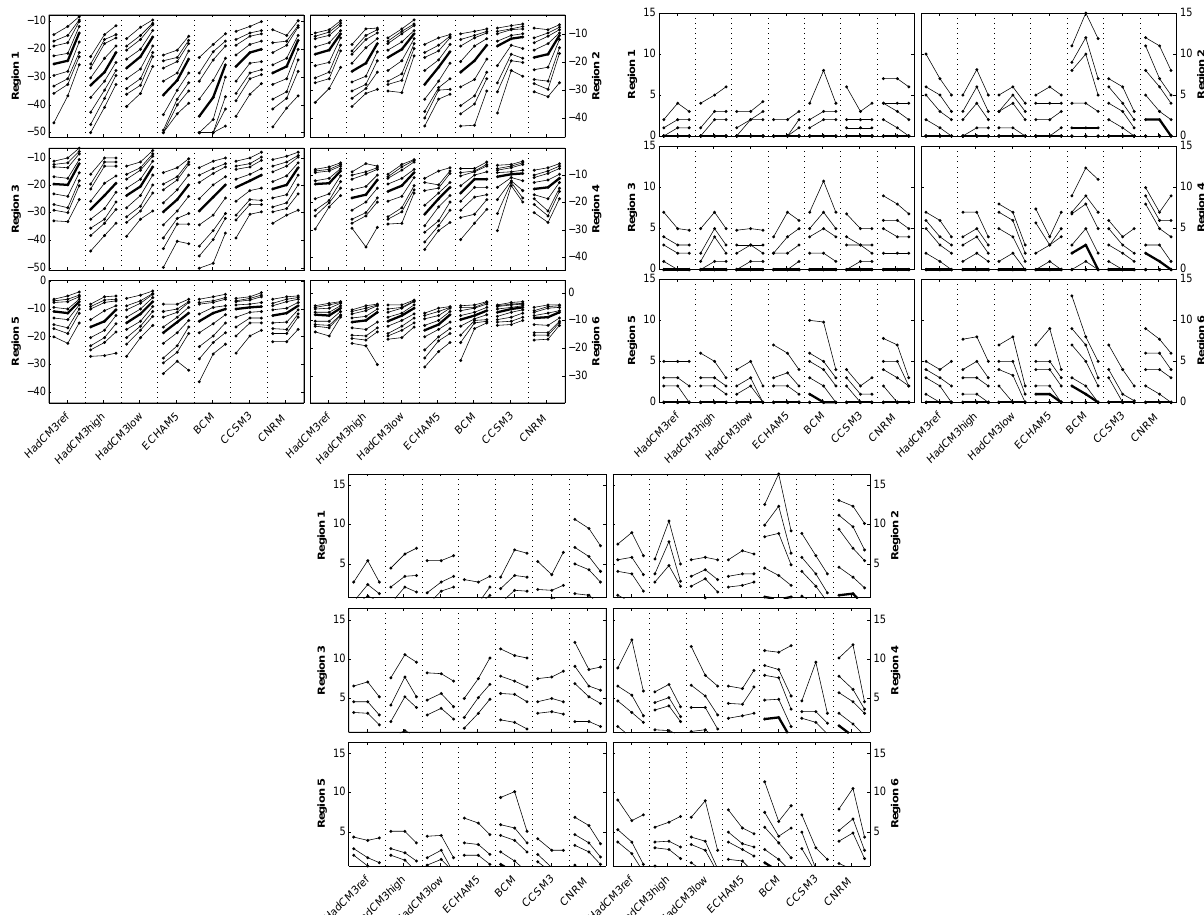
Fig. 12. Same as for Fig. 11 but for three CHM variables: (a) cold hardiness level, (b) number of spring frost events, and (c) the maximum frost damage. The 50% is highlighted by a thicker